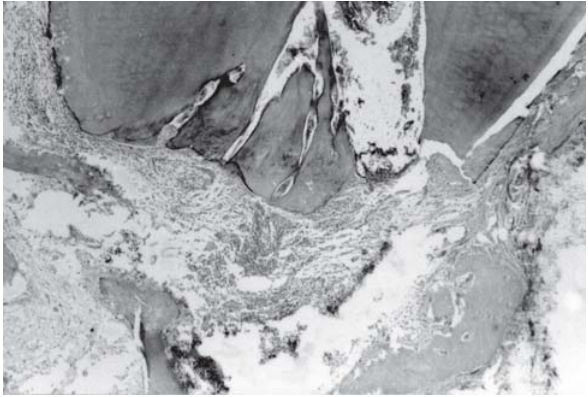
FIGURE 1- Group I – no root canal dressing – No biological closure and cement displaying areas of resorption. H.E.,